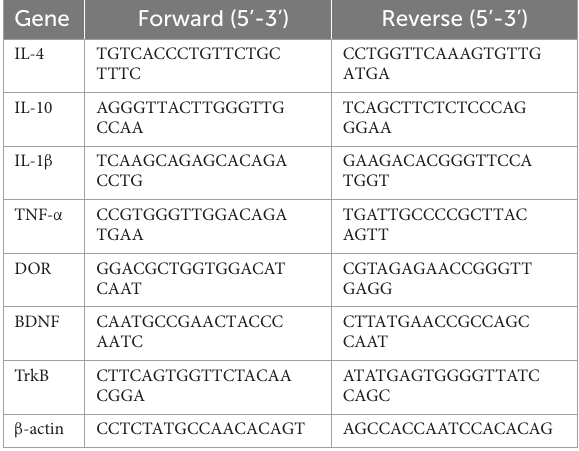
TABLE 1 Primer information in this